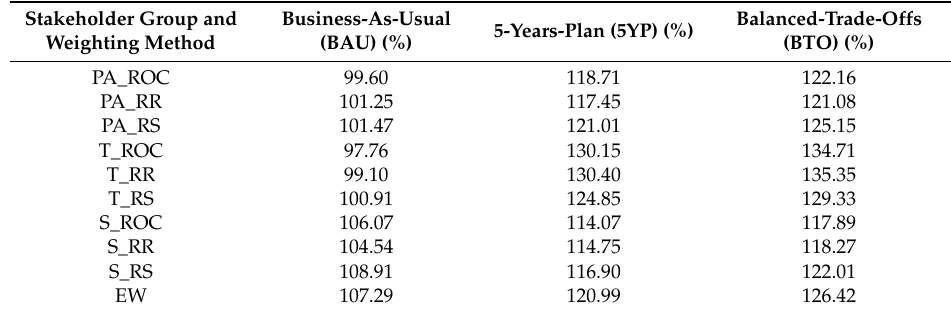
Table 5. Integrated ESS indices at the final year of the simulation (2040) for all stakeholder groups and weighting methods in comparison to the initial condition of 2015, which is set to